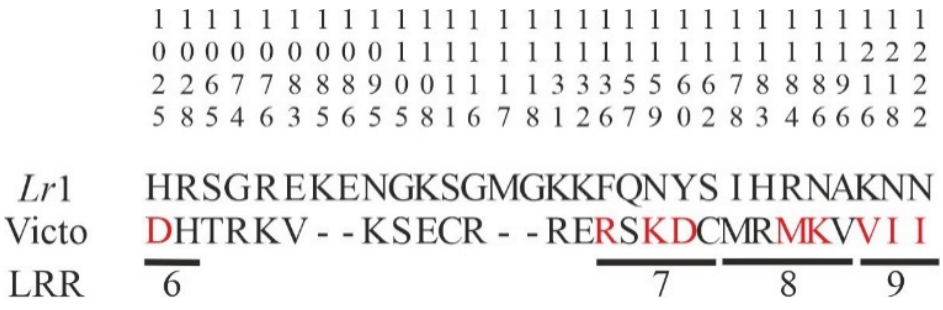
Figure 5. Polymorphisms between the Lr 1 (GenBank ABS29034.1) and the ‘Victo’ protein sequences are reported from 1025 to 1222 of the ‘Glenlea’ amino acid sequence. The vertical number gives the amino acid positions in the Lr 1 protein. Deletions are shown as dashes. The polymorphic sites detected in the leucine-rich-repeat (LRR) domain are indicated. In red are highlighted the amino acids that determine modifications in terms of physicochemical properties.